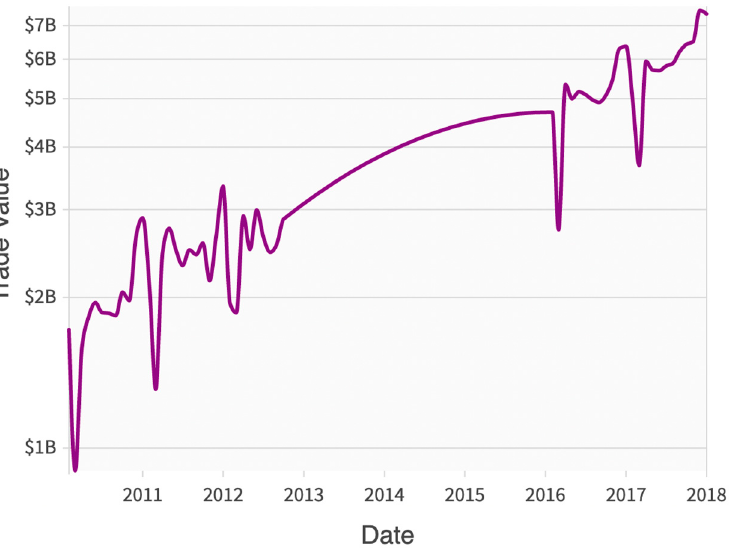
Figure 1. Trade between Vietnam and China (2010–2018). Source: Observatory of Economic Com- plexity (OEC 2022).